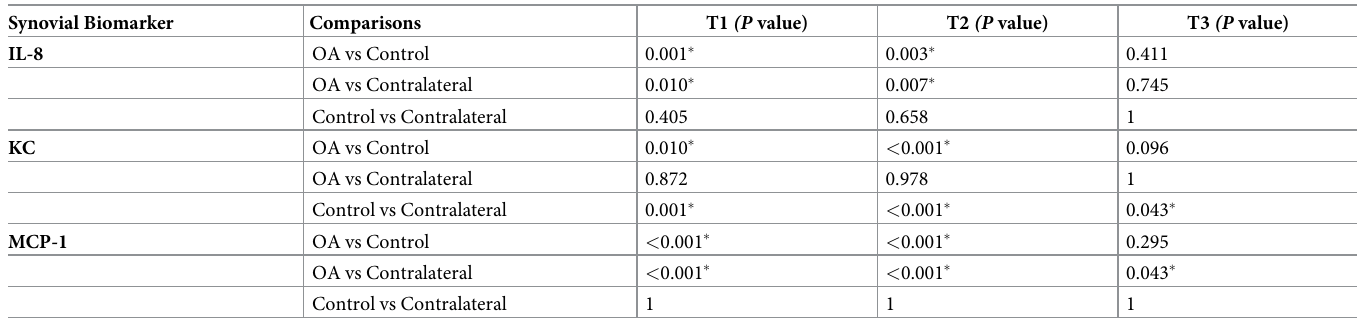
Mixed linear regression model adjusted for age and weight followed by post hoc pairwise comparison with Bonferroni correction at each time point. �